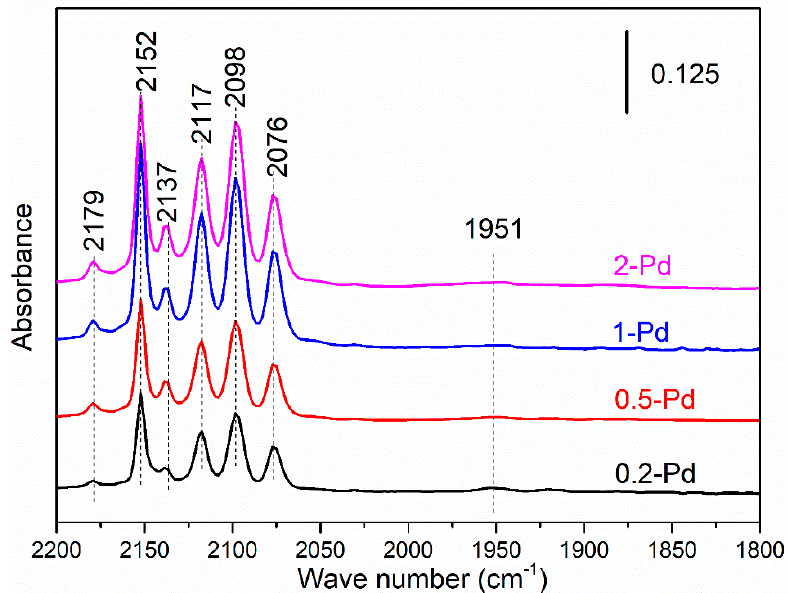
Figure 2. CO in situ FTIR spectra of 2-Pd, 1-Pd, 0.5-Pd, 0.2-Pd (Temperature: 80 ◦ C; Flow: 1000 ppm CO, balanced with N 2 , 500 mL/min).